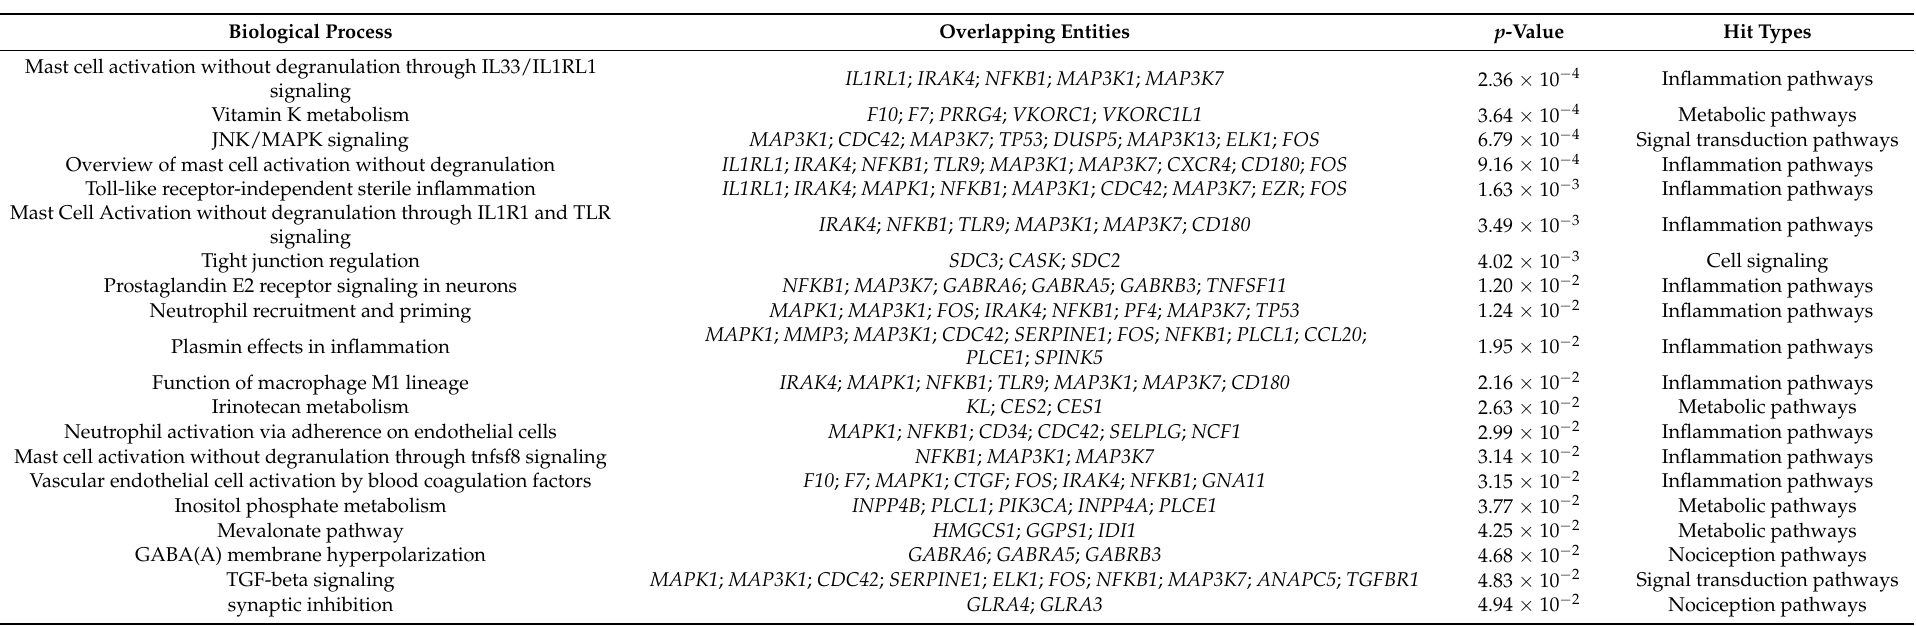
Table 6. A list of statistically significant biological processes in the age group 50 as compared to age group 30 ( p < 0.05, FDR), sorted according to the p -value by Fisher’s exact